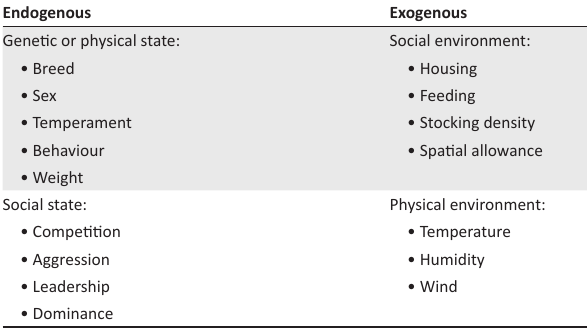
TABLE 1: The exogenous and endogenous stressors that affect